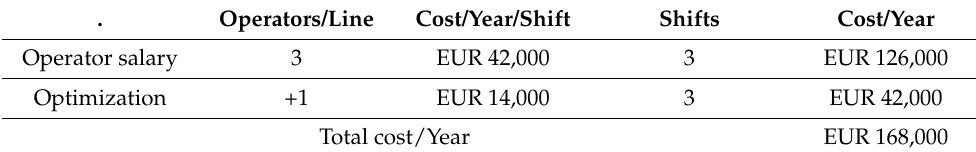
Table 2. Annual cost data with salaries if the automated systems are not implemented. .